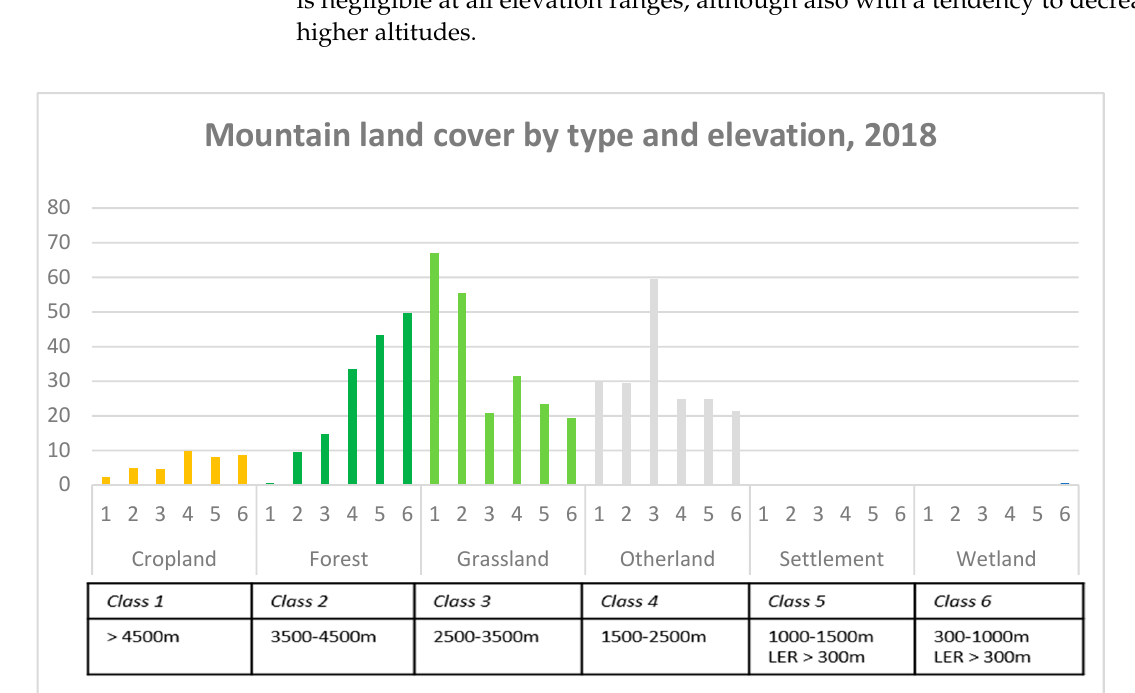
Figure 3. Mountain Green Cover Index by regions as defined by the System of Integrated Environ- mental and Economic Accounting (SEEA).